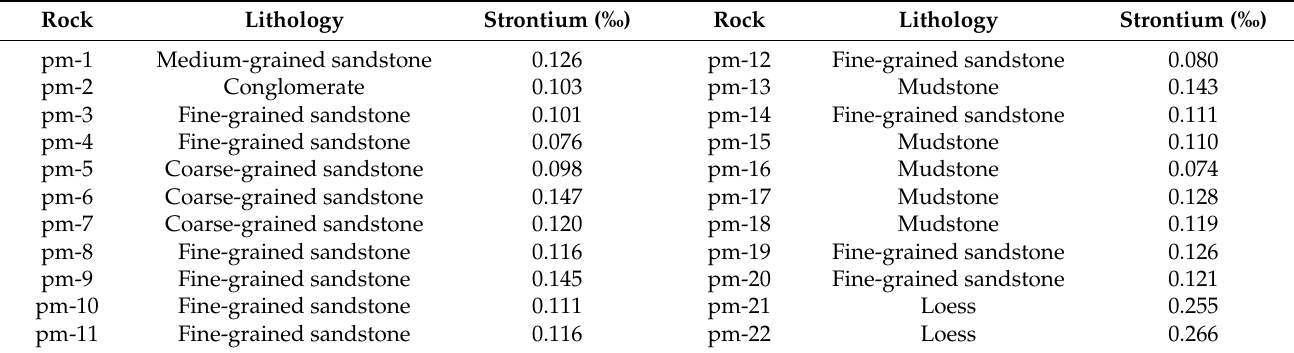
Figure 8. Sr content of strata in hydrogeological boreholes G019 ( a ) and G020 ( b ). Table 3. Sr content in rock sample profiles.